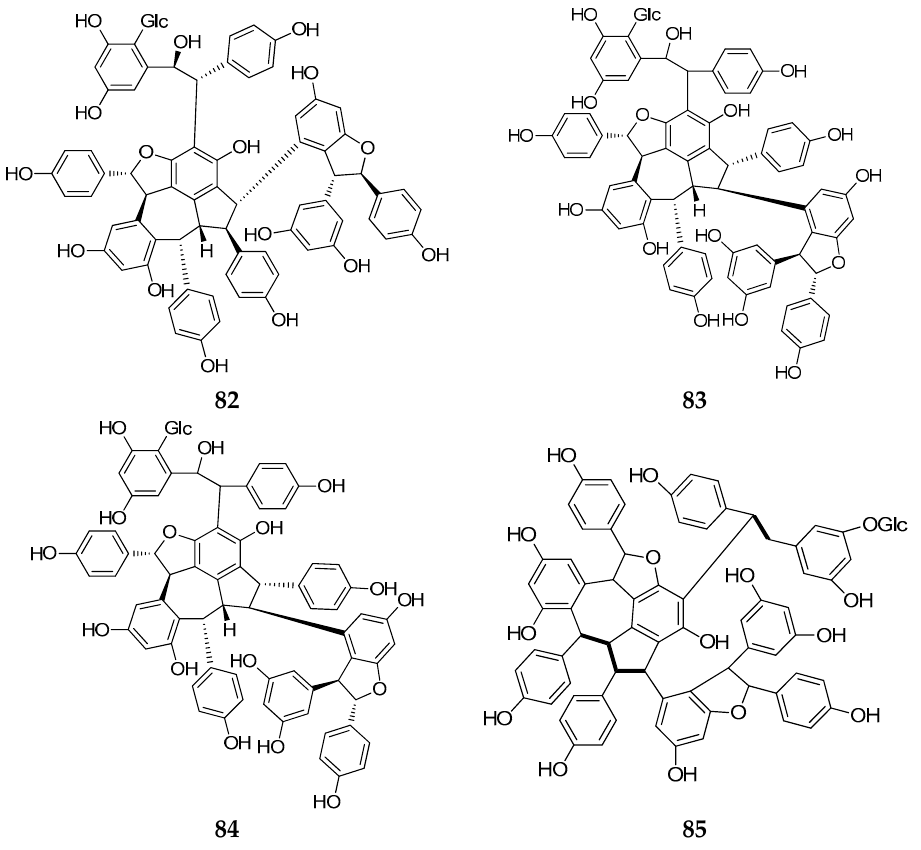
Figure 6. The structures of resveratrol pentamers ( 82 – 85 ).